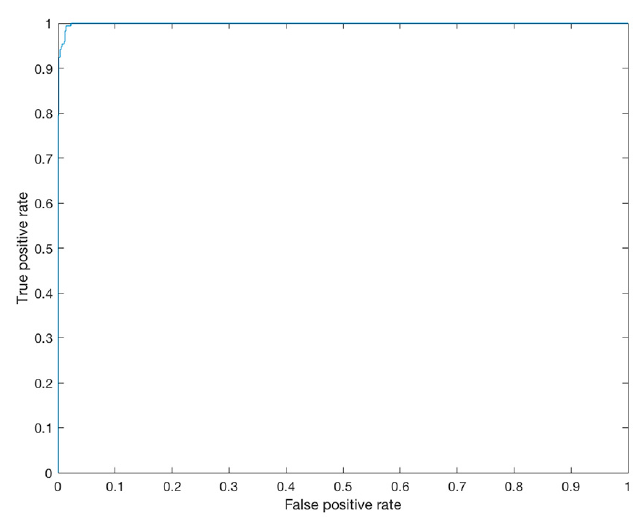
Figure 6. Test accuracy illustrated by tradeoffs between the sensitivity and specificity.